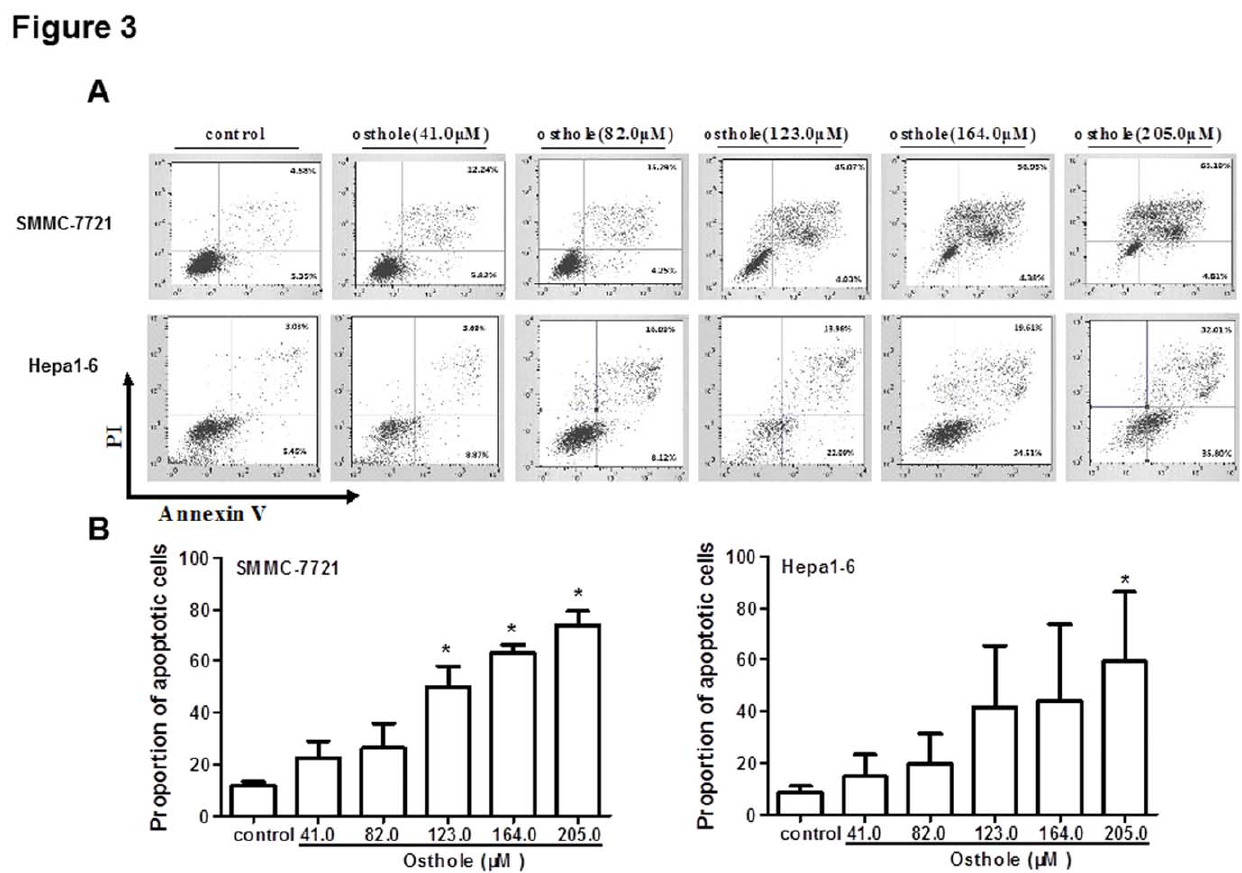
Figure 3. Effects of Osthole on apoptosis of HCC cells. (A) Induction of apoptosis of SMMC-7721 and Hepa1-6 cells after osthole treatment. SMMC-7721 and Hepa1-6 cells were treated with osthole at doses of 0, 41.0, 84.0, 123.0, 164.0 and 205.0 m M for 48 h. Apoptosis was measured by flow cytometry. (B) Statistical analysis of the percentages of the apoptotic cells. Data shown were representatives of three experiments.